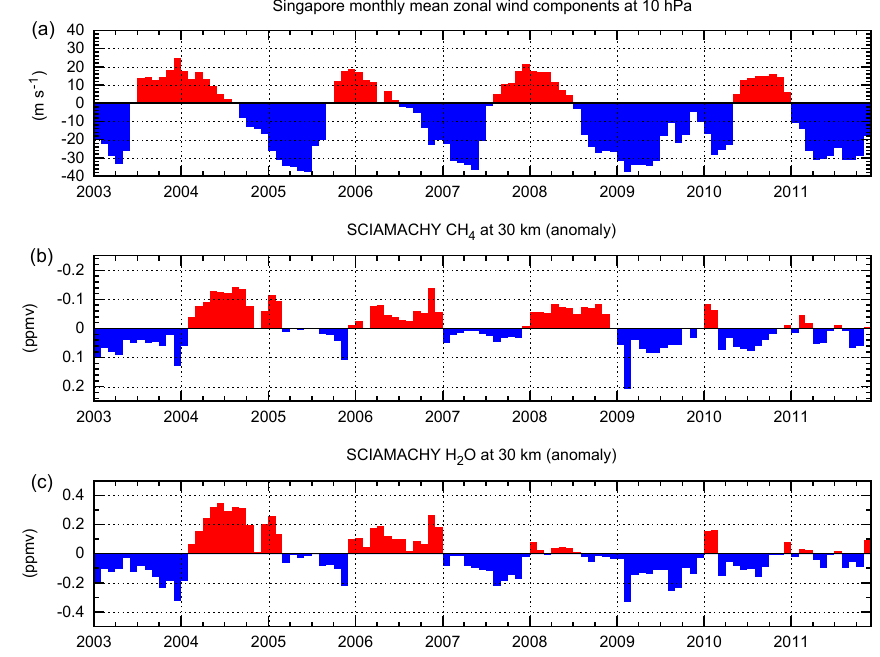
Figure 9. Time series of methane and water vapour anomalies at 30km (b, c) and Singapore zonal wind at 10hPa, corresponding to about 30km (a) . Note that the vertical axis of the methane data is inverted and scaled differently than for water vapour.